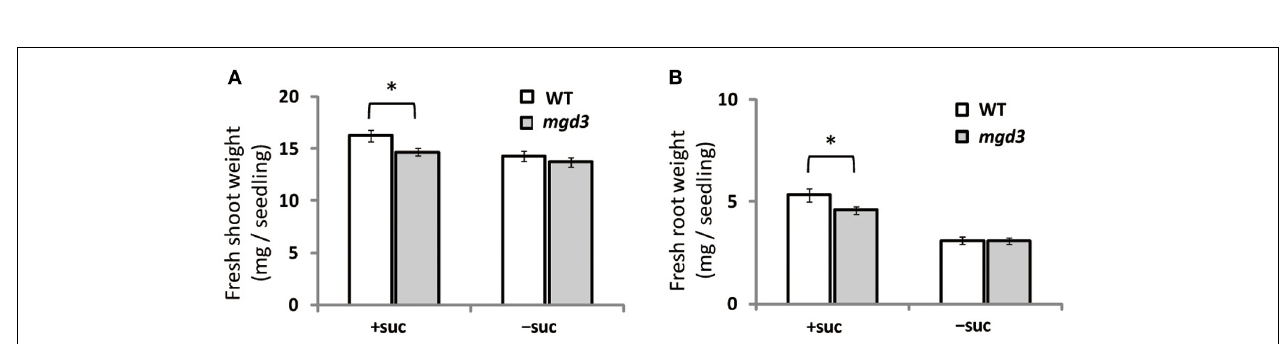
FIGURE 1 | Gene expression in Arabidopsis WT seedlings grown with or without exogenous sucrose. Plants grown on MS agar with 1% (w/v) sucrose ( + suc) or without sucrose [0.53% (w/v) mannitol as the osmotic control; − suc] for 7d were then transferred to ½MS agar with or without sucrose, respectively, for 7d. Relative mRNA abundance of genes upregulated during Pi starvation ( MGD2 , MGD3 , DGD1 , DGD2 , NPC5 , IPS1 ,